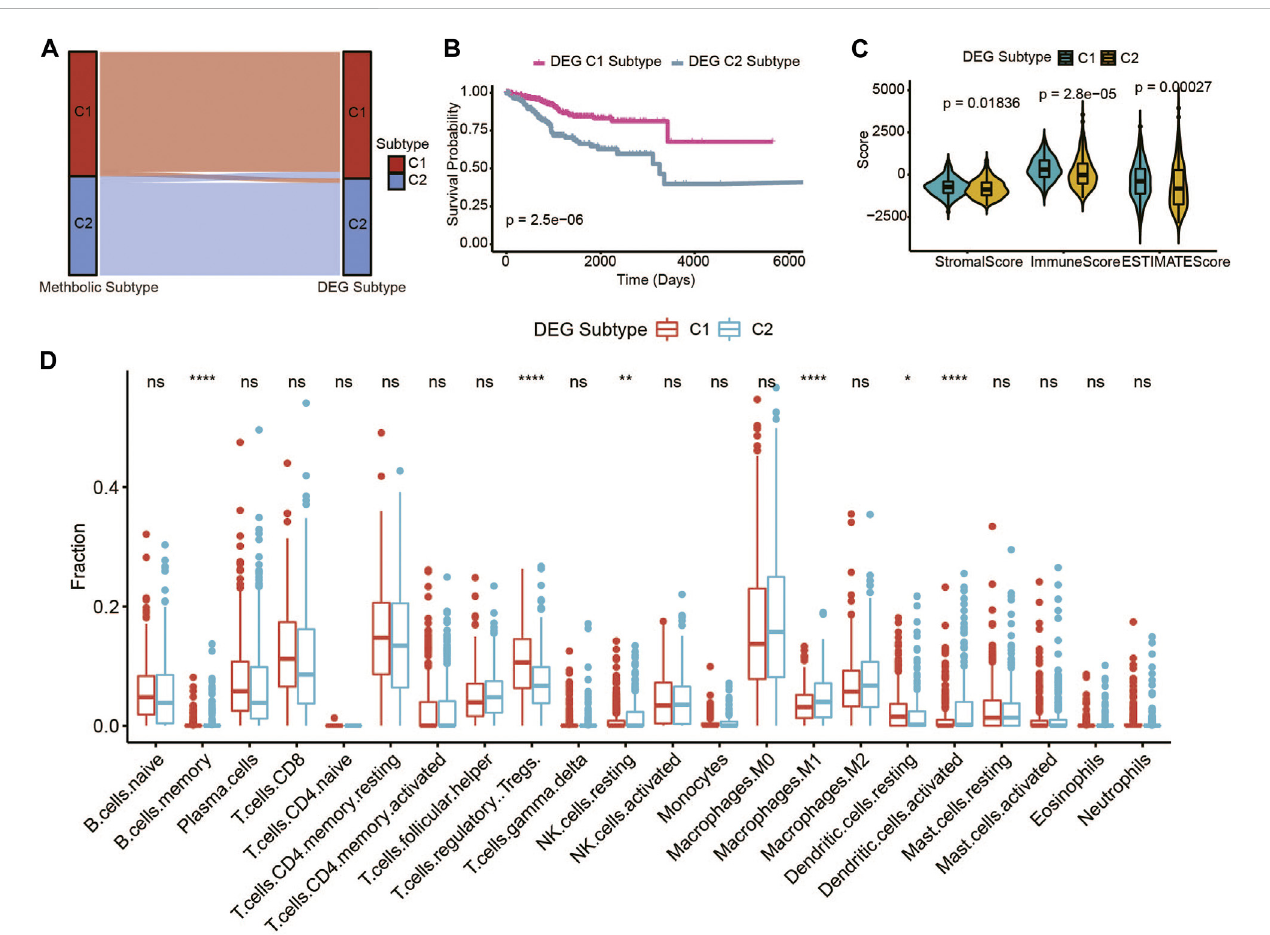
FIGURE 3 Identi fi cationofUCECgene-clustersbasedonDEGsoftheUCECmetabolicsubtype. (A) Sankeydiagramshowsthe fl owchangebetweenthemetabolic subtypeandDEGsubtype. (B) TheOSofthetwoDEGgeneclustersinUCECpatients. (C) Theviolinplotofstromalscore,immunescore,andESTIMATEscore of the two DEG gene clusters. (D) Immune cell components that differ between the two DEG gene clusters in UCEC